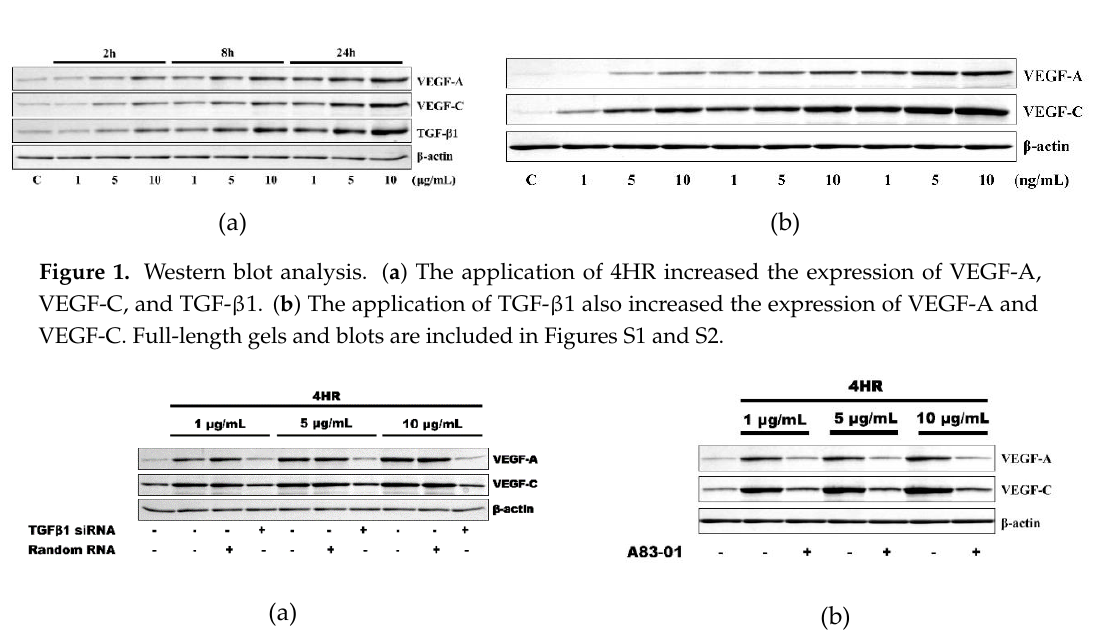
Figure 2. Inhibition assay. ( a ) The application of TGF- β 1 small interfering RNA (siRNA) inhibited the expression of VEGF-A and VEGF-C, which was induced by 4HR application. ( b ) ALK5 inhibitor, A83-01, also showed a similar effect to that of TGF- β 1 siRNA on the VEGFs expression by 4HR in human umbilical vein endothelial cells (HUVECs). Full-length gels and blots are included in Figures S3 and S4.